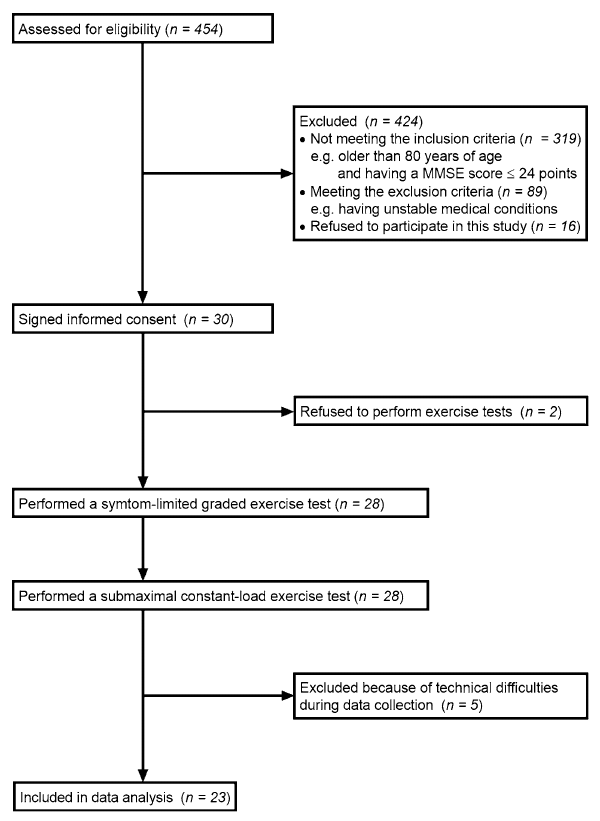
Figure 1. Flow diagram of study participants. MMSE Mini-Mental State